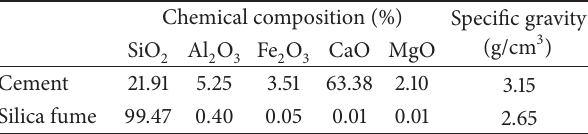
Table 1: Properties of cement and silica